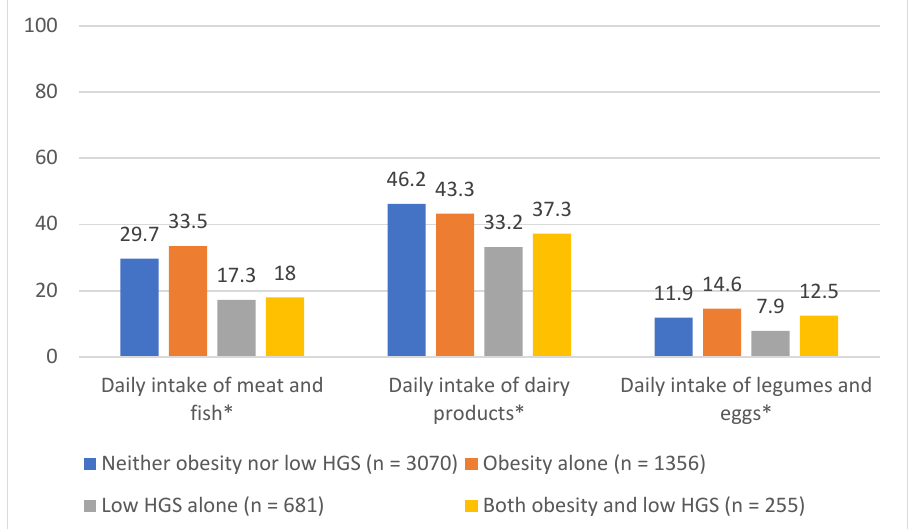
Figure 1. Daily intake of different protein sources according to the presence/absence of obesity coexisting with low handgrip strength, obesity alone and low handgrip strength alone; p -value calculated with chi-squared test; * significant difference between the groups observed.